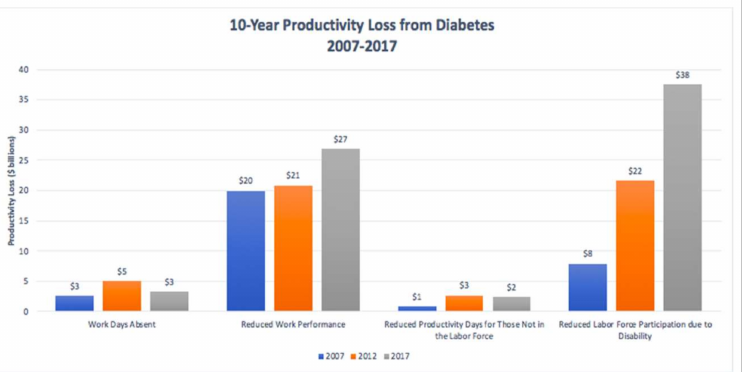
Figure 2. Productivity loss in billions from workdays absent, reduced work performance, reduced productivity days for those not in the labor force, and reduced labor force participation due to disability—rounded to the nearest tenth (blue—2007, orange—2012, gray—2017)